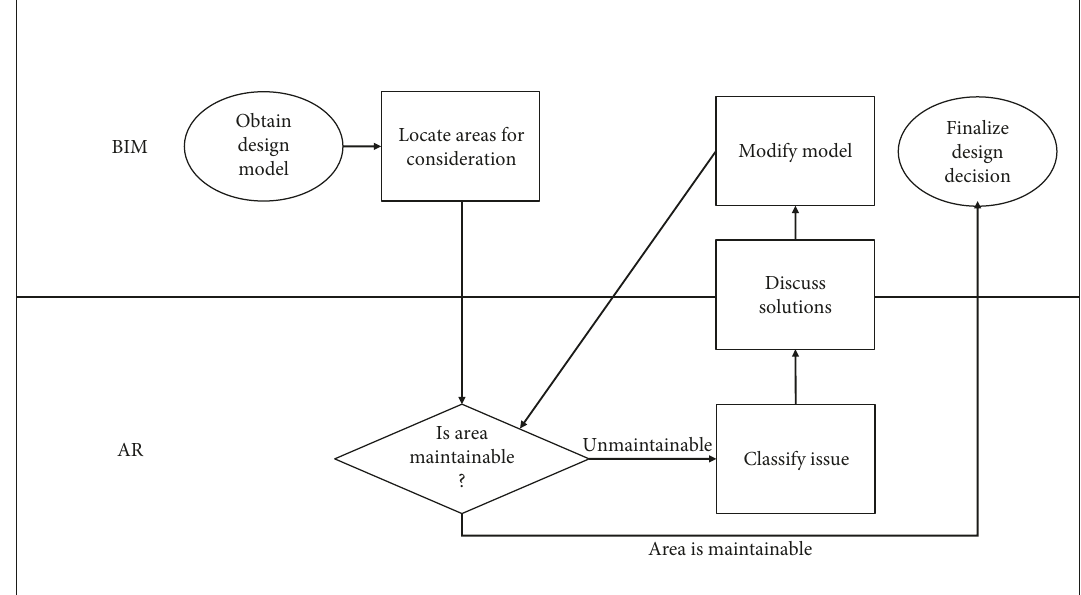
Figure 5: Hybrid visualization